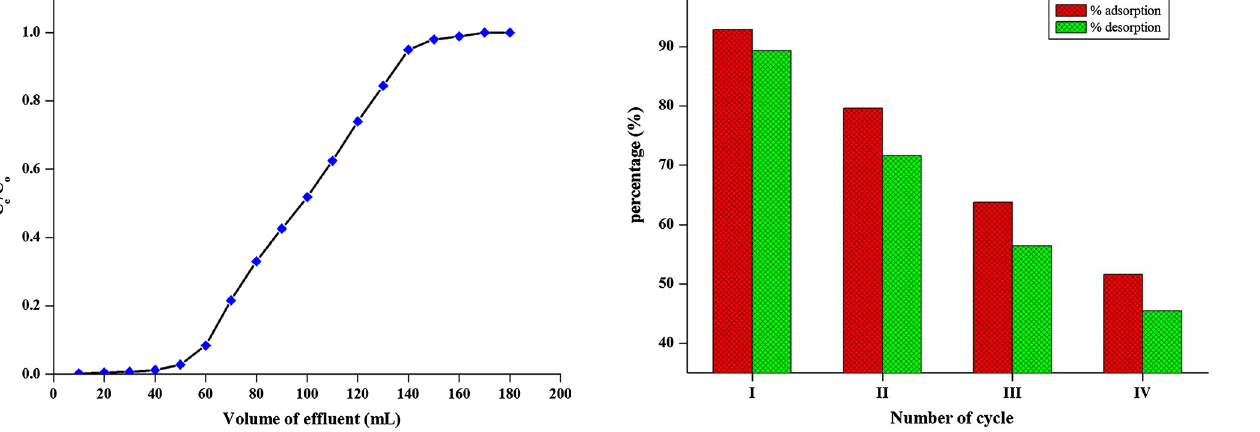
Fig. 14 Breakthrough curve (conditions; adsorbent = 0.05 g; CV = 20 mgL −1 ; flow rate = 1 mL min −1 )